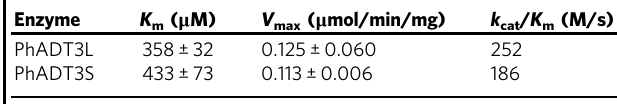
Table 3 Kinetic parameters of recombinant petunia PhADT3 isoforms with prephenate as substrate